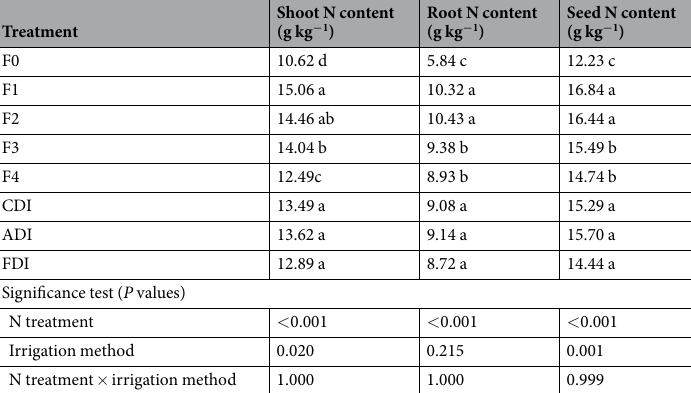
Table 3. Mean N contents in shoots, roots and seeds of sweet-waxy maize for different irrigation methods and N treatments. P values were shown ( P < 0.05, significance; P > 0.05, no significance). Different small letters in the same column are significantly different for various N treatments or irrigation methods ( P < 0.05), and the same letters are not markedly different for various N treatments or irrigation methods ( P >